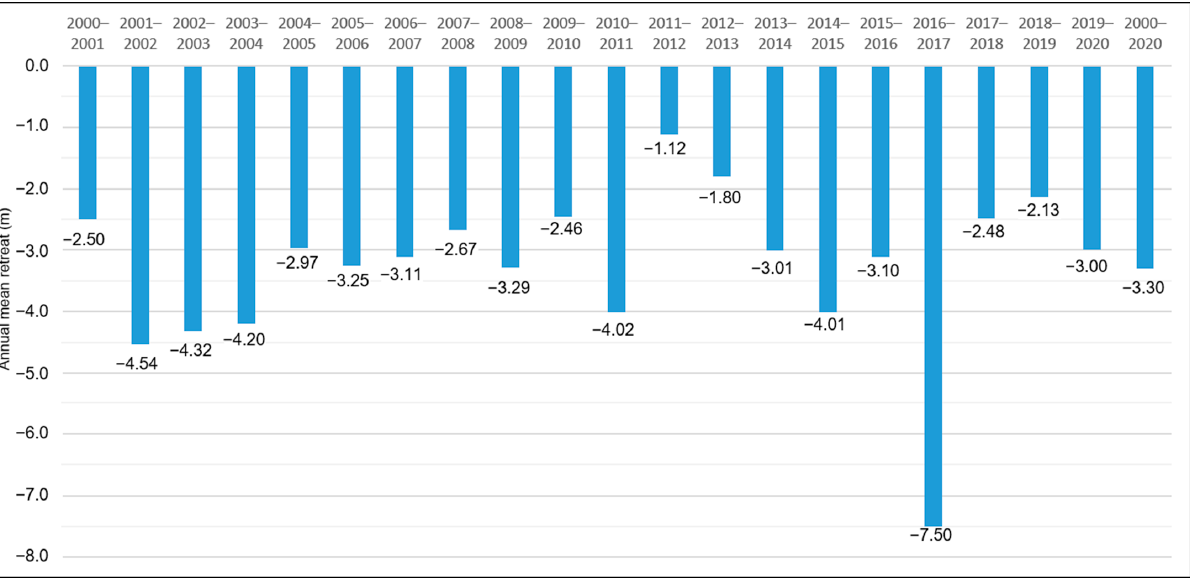
Figure 5. Cumulative historical eroded area and mean retreat rates.